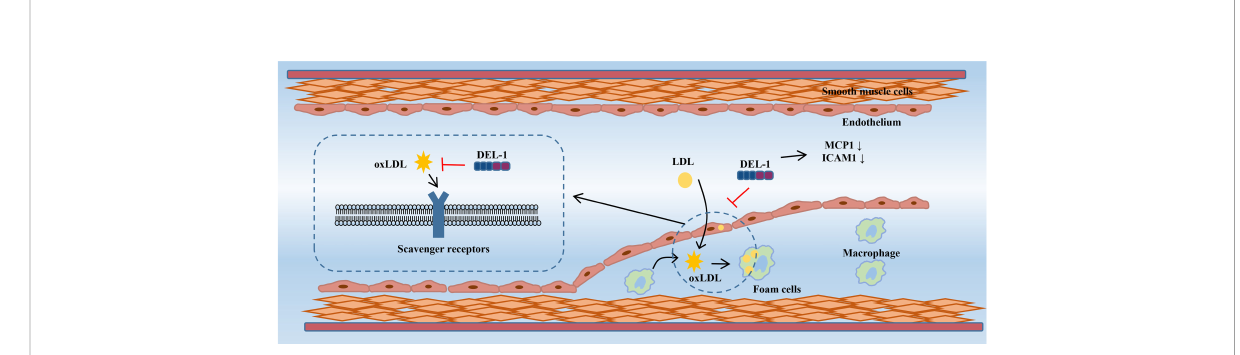
FIGURE 3 DEL-1 binds directly to oxLDL to block its binding to scavenger receptors and exert signi fi cant anti-atherogenic effects. In addition, DEL-1 reduced the expression of MCP1 and ICAM1 in the endothelial cell. DEL-1, developmental endothelial locus-1; oxLDL, oxidized low-density lipoprotein; MCP1, monocyte chemotactic protein-1; ICAM1, intercellular adhesion